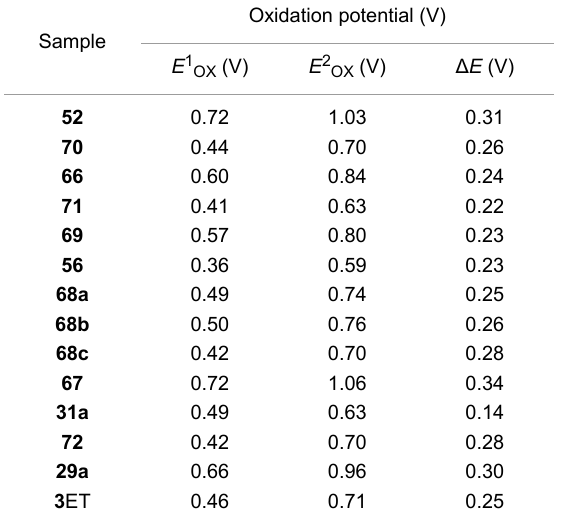
Table 5: Redox potential of ET 3 and its analogues, ACN solution of 0.1 M NaClO 4 .